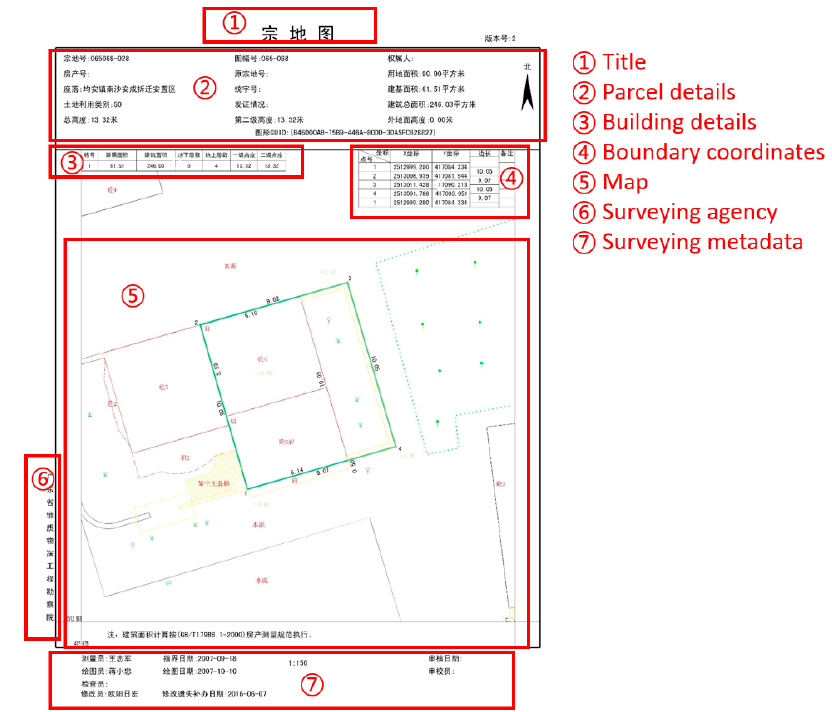
Figure 12. Parcel map of homestead land (source: http://www.shunde.gov.cn/data/2016/09/23/1474603486.jpg, accessed on 26 October 2021 ).